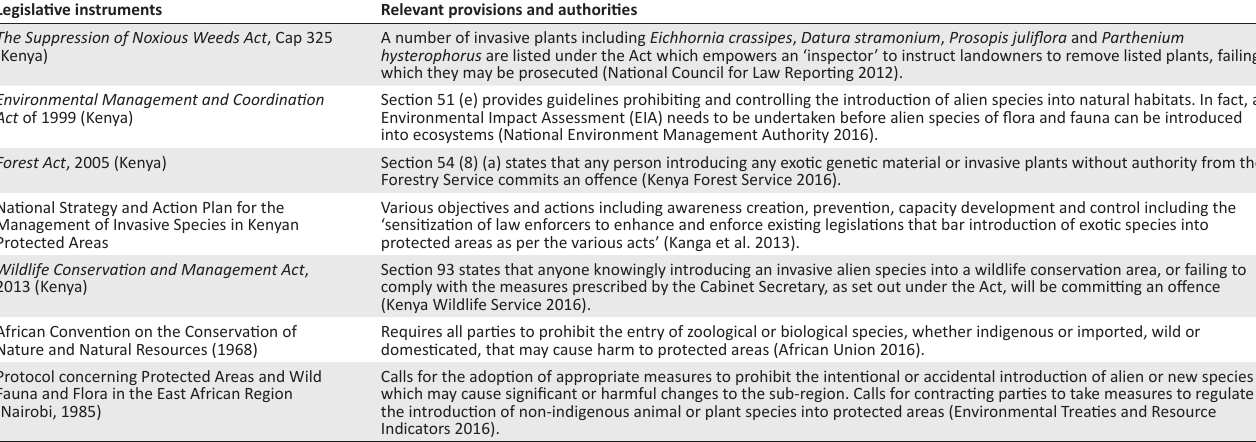
TABLE 2: Some national, regional and African legislation, policies, conventions and treaties that make reference to invasive alien